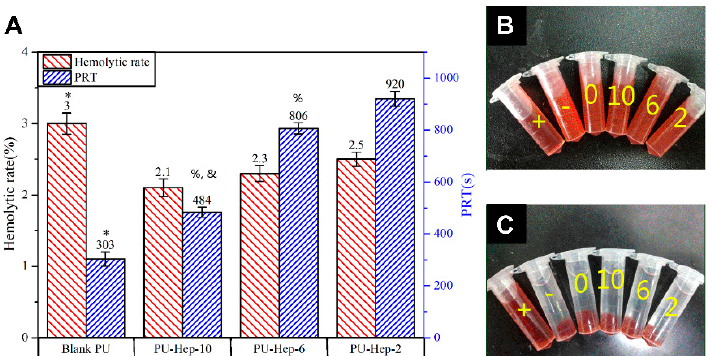
Figure 4. ( A ) Hemolytic rate and plasma recalcification time (PRT) of PU and heparinized PU films. Samples marked with (*) are significantly different from PU film with immobilized heparin. Samples marked with (%) are significantly different from the PU-Hep-2 group ( p < 0.05). Samples marked with (&) are significantly different from the PU-Hep-6 and PU-Hep-2 groups ( p < 0.05). ( B , C ) Photographs of blood/saline mixture before (B) and after (C) centrifugation. Labels 0, 2, 6, 10, - and + represent the blank PU, PU-Hep-2, PU-Hep-6, PU-Hep-10 films, negative and positive controls, respectively.